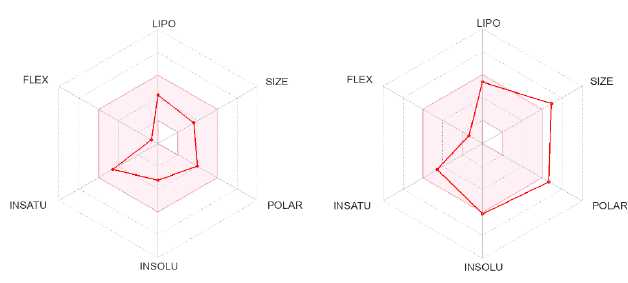
Figure 10. Bioavailability radars of 3 ( left ) and 4 ( right ).